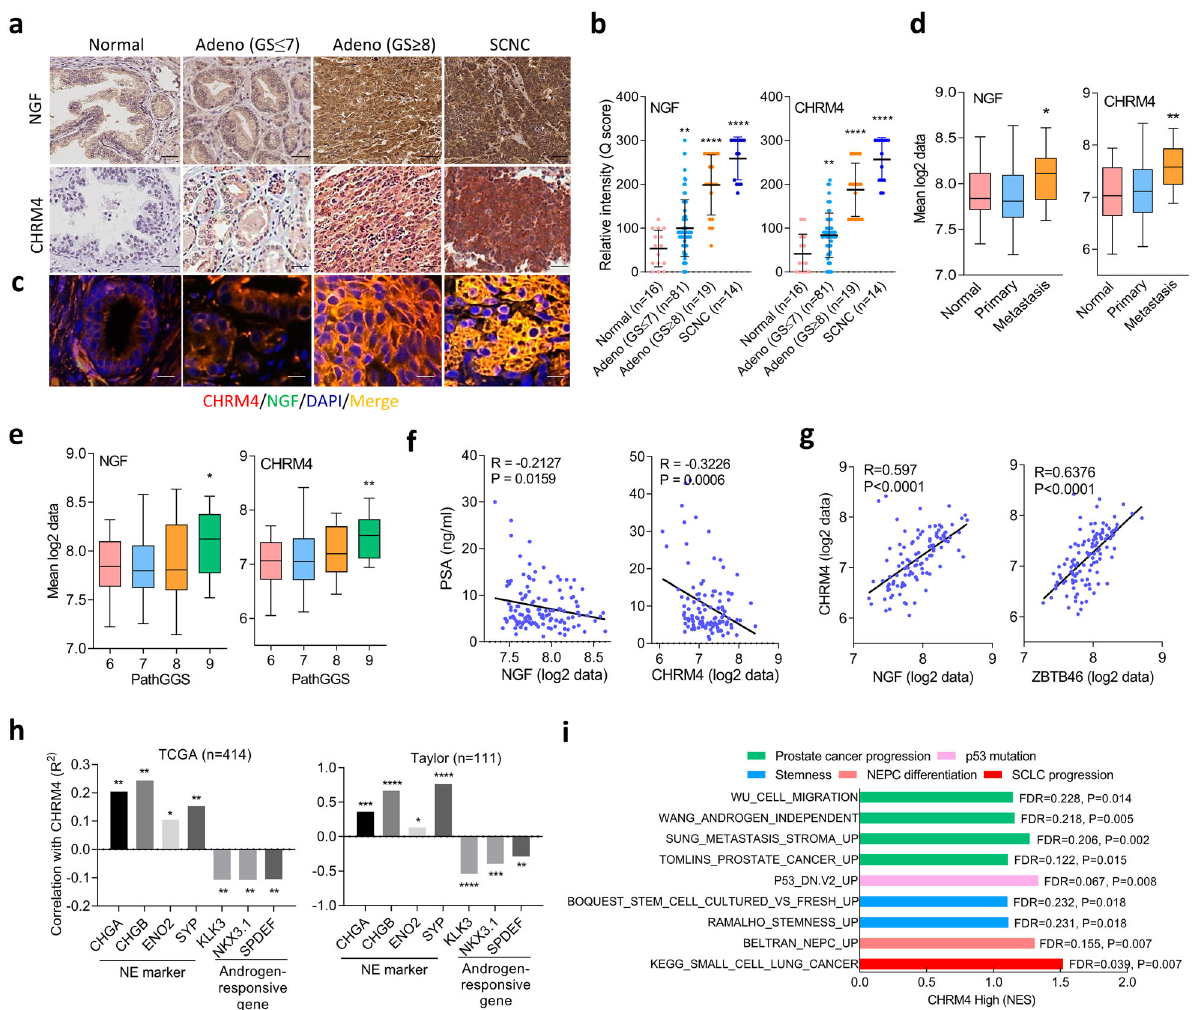
Fig. 6 Positive associations among the NGF, CHRM4, and neuroendocrine markers in clinical samples. a, b IHC staining ( a ) and relative intensities ( b ) of the NGF and CHRM4 of a prostate cancer TMA consisting of normal tissues ( n = 16), adenocarcinomas with a Gleason score of ≤ 7 ( n = 81), adenocarcinomas with a Gleason score of ≥ 8 ( n = 19), and SCNCs ( n = 14) from Duke University School of Medicine. Scale bars, 100 μ m. Data are presented as the mean ± SEM. * vs. normal tissues. * p < 0.05, **** p < 0.0001; by a two-way ANOVA. c Immuno fl uorescence staining of the tissue microarray (TMA) with antibodies for the CHRM4 (red) and NGF (green). Nuclei were visualized with DAPI staining (blue). Scale bars represent 20 µ m. d Mean mRNA expression levels of the NGF and CHRM4 in human normal prostate ( n = 28), primary ( n = 98), and metastatic ( n = 13) prostate cancer samples from the Taylor prostate cancer dataset 30 . * vs. normal tissues. * p < 0.05, ** p < 0.01; by a two-way ANOVA. e Mean mRNA expressions of the NGF and CHRM4 in patient samples in the Taylor prostate cancer dataset 30 by Gleason scores. * vs. Gleason score of 6. Signi fi cance was determined by a